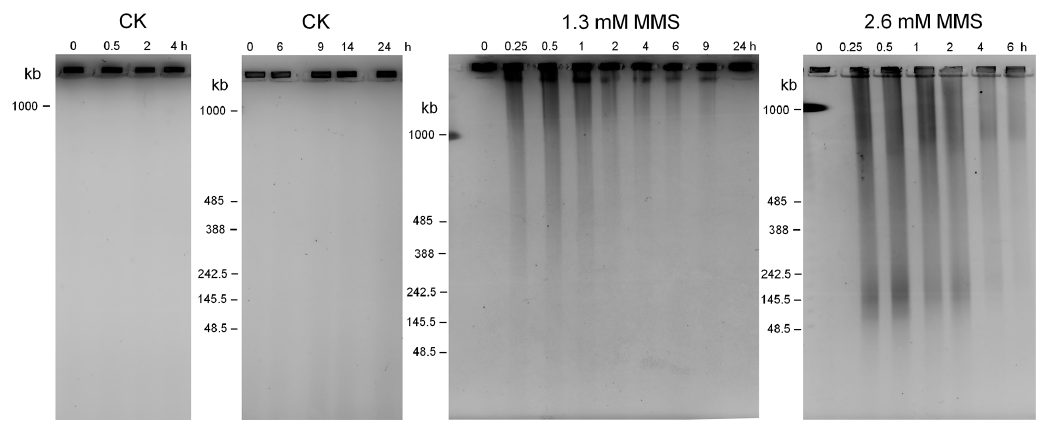
Figure 2. Pulsed field gel electrophoresis (PFGE) analysis of total DNA from untreated culture (CK) and the cultures treated with 1.3 mM and 2.6 mM MMS. Total DNA from about 4 × 10 8 cells was analyzed for each sample. DNA fragments are visible below the wells in treated samples.